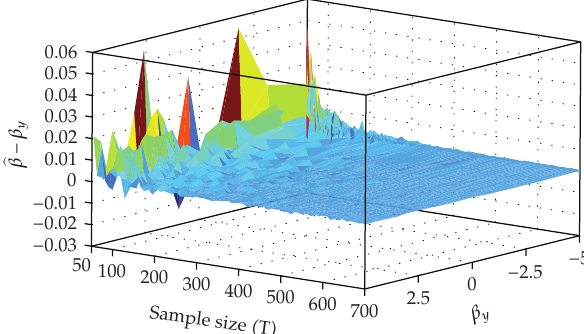
(cid:9) Figure 1: Finite-sample behavior of β − β y : sample size and β y range from T (cid:7) 50–700 and − 5 to 5, (cid:7) σ 2 (cid:7) 1; μ (cid:7) 4 . 20; μ (cid:7) 0 . 70. Number of replications respectively; ρ y 1 (cid:7) − 0 . 15; ρ y 2 (cid:7) 1 . 5; ρ x (cid:7) 4; σ 2 y x y x (cid:2) for each coordinate (cid:3) : 20; grid density: 70 × 30. (cid:9) Table 1: Finite-sample behavior of β − β y : mean and standard deviation. DGP parameters Sample